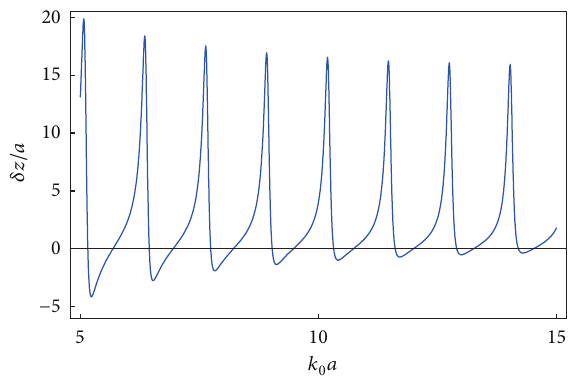
Figure 4: Longitudinal shift as a function of the width 𝑘 0 𝑎 of a dielectric slab with constant refractive index 𝑈 0 = 1.5 . Here 𝜀 = −0.995